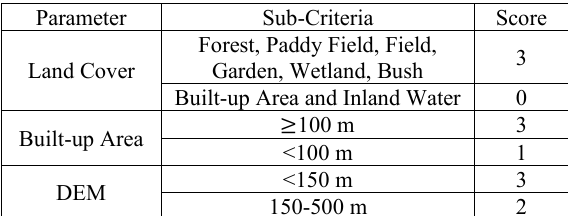
Table 2 . Parameter Scoring in Geographic